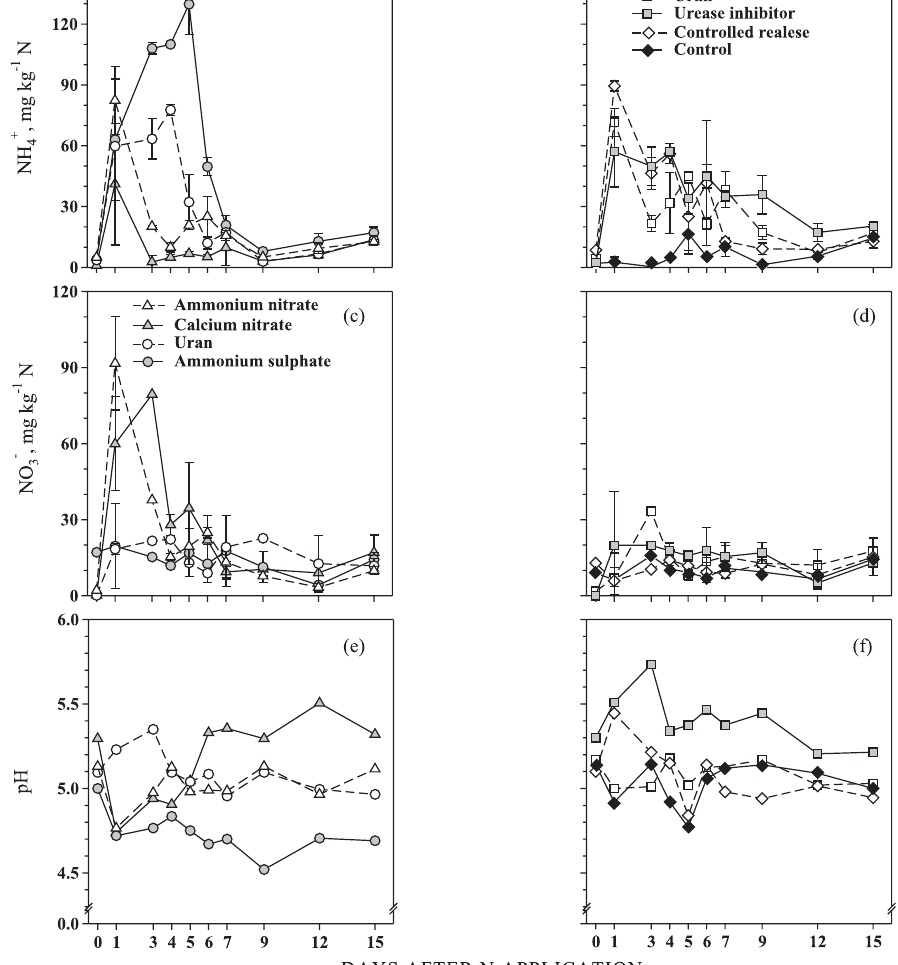
Figure 2. Ammoniun contents (NH 4+ -N; a, b), nitrate contents (NO 3- -N; c, d) and soil pH values (e, f) for the 15 day period after application of the N fertilizers to a Gleysol (0 to 0.10 m) in the South of Brazil. Vertical bars mean standard deviation of the mean ( n